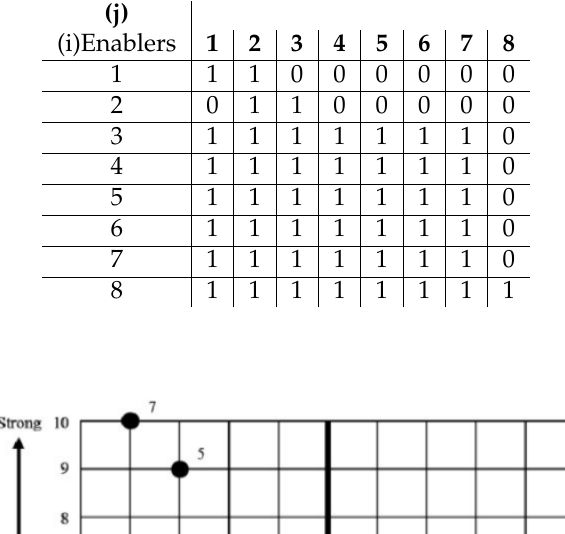
Table 2. Samples on the reachability matrix